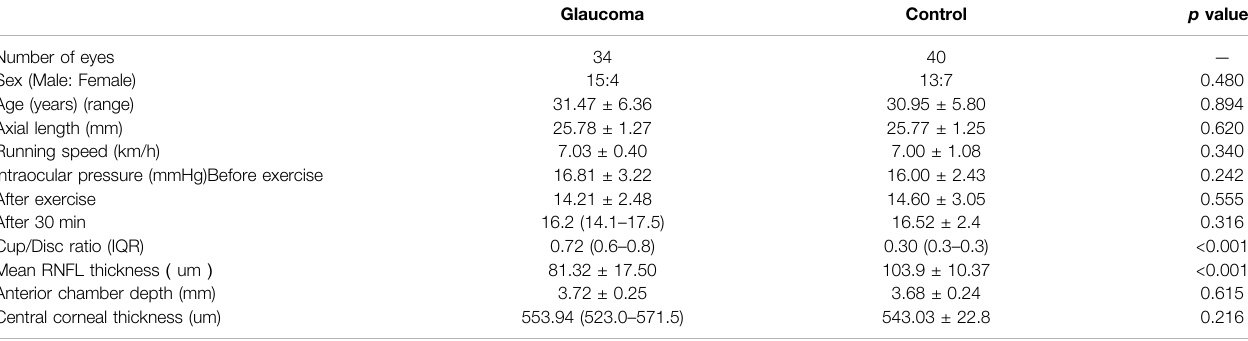
TABLE 1 | Demographic and baseline characteristics of patients with glaucoma and control subjects.